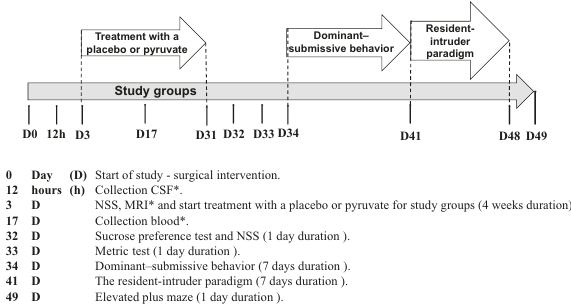
Fig. 1 Experimental timeline. *Rats subjected to behavioral tests did not undergo MRI, CSF collection, or blood collection. CSF Cerebrospinal fl uid; MRI Magnetic resonance imaging; NSS Neuro- logical severity